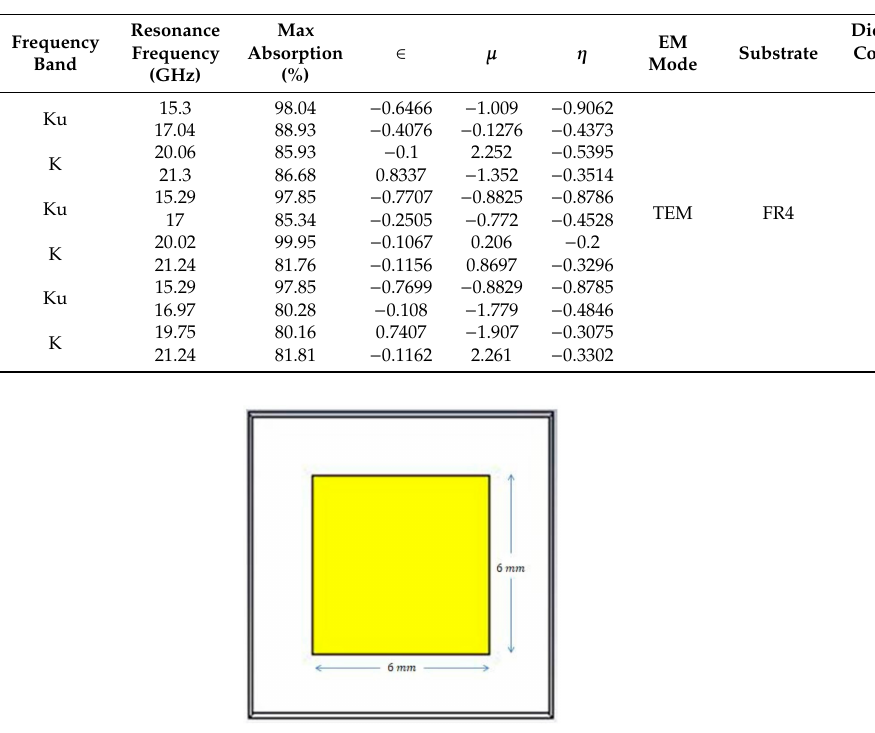
Table 3. Absorption at di ff erent polarizing angles in TEM mode for FR4 substrate.